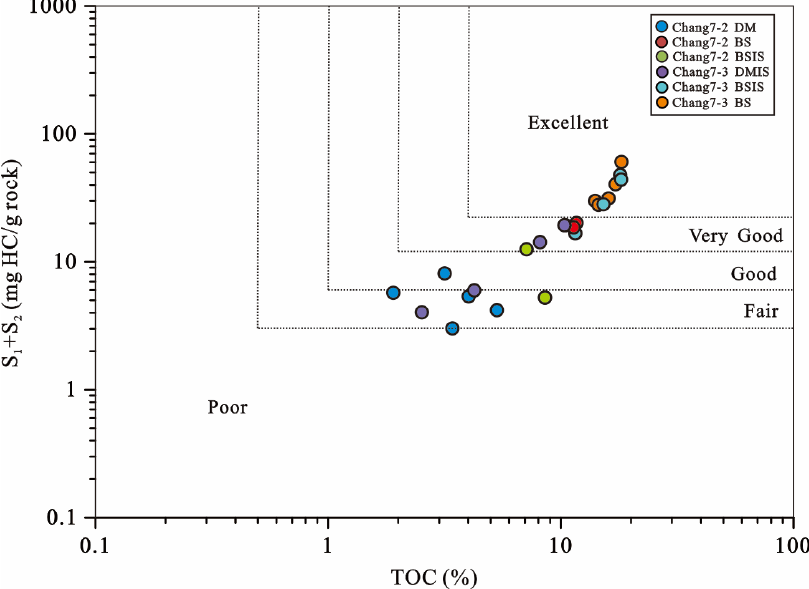
Figure 3. The cross-plot of generative potential (S 1 + S 2 ) and TOC. DM—dark mudstones; BS—black shales; BSIS—black shales interbedded with sandstones; DMIS—dark mudstones interbedded with sandstones.